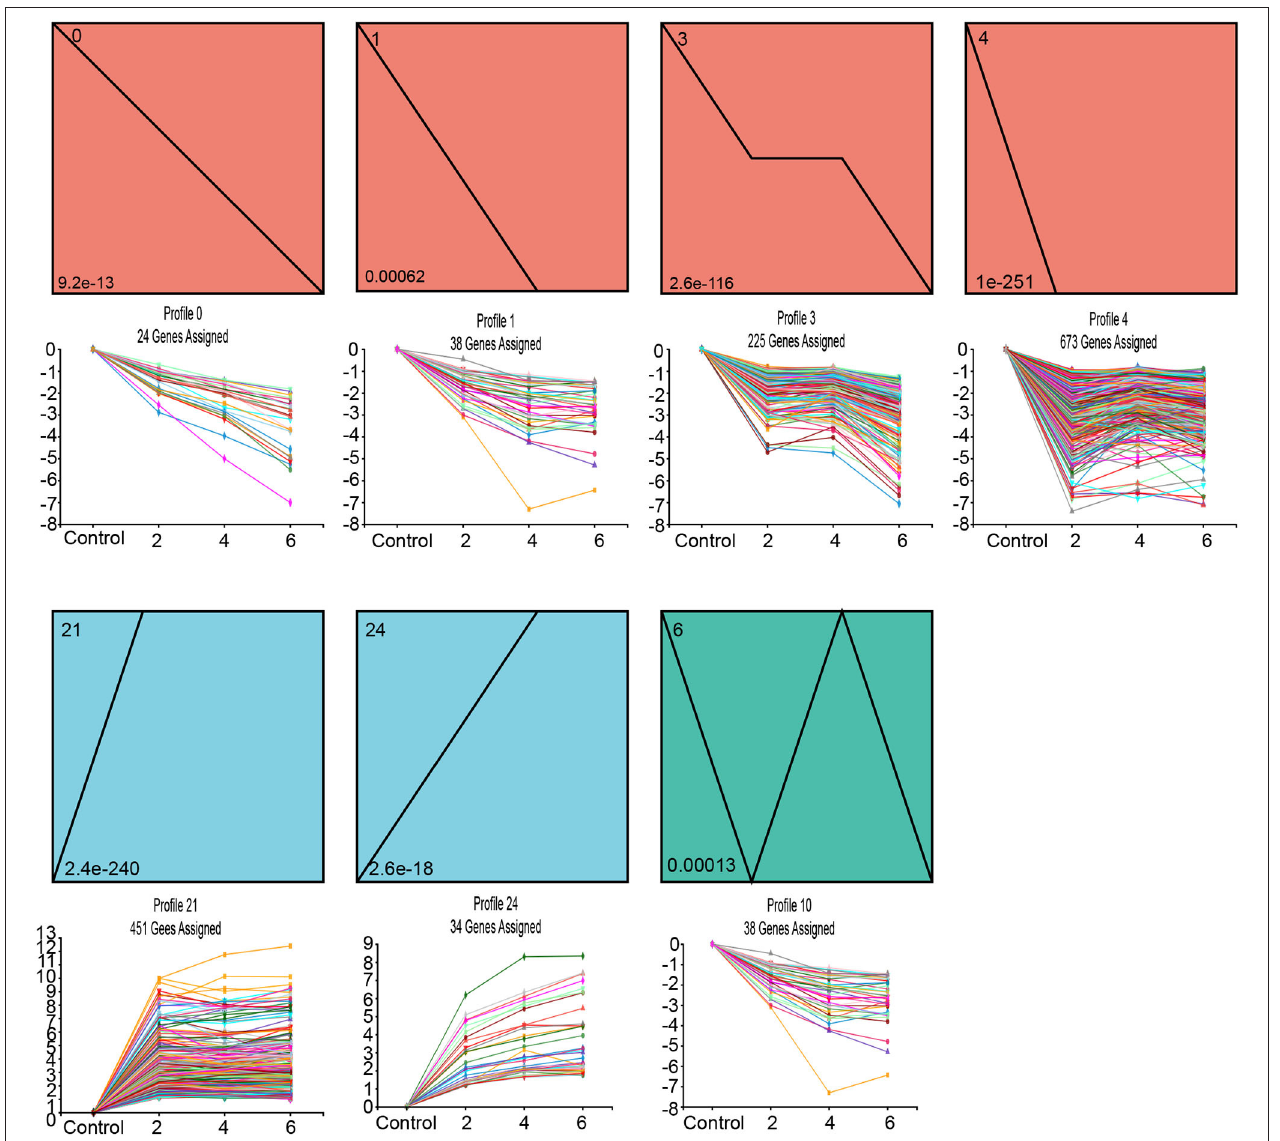
FIGURE 5 | Short Time-series Expression Miner (STEM) analysis of darkness and salt treatment-enriched 1546 SAGs across three time points. Each square box indicates a type of expression profile, with the profile order on the upper left and the P -value on the bottom left. Only the significantly enriched cluster profile with a P-adjust < 0.05 threshold is